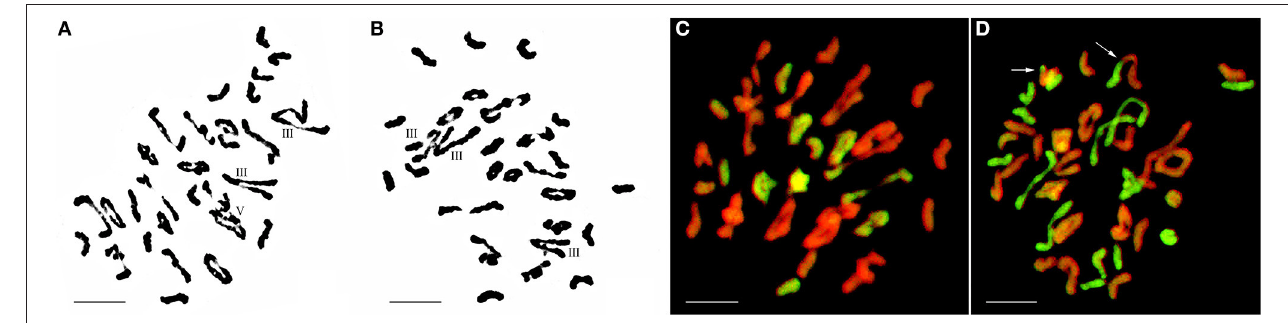
FIGURE 3 | Chromosome configuration in PMC MI for wheat- E. elongata F 2 hybrids. (A) Chromosome configuration of F 2 -1: 2 n = 10I + 14II + 2III + 1V; (B) Chromosome configuration of F 2 -2: 2 n = 7I + 18II + 3III; (C) E. elongata chromosome configuration of F 2 -1: 2 n = 5I + 6II; (D) E. elongata chromosome configuration of F 2 -2: 2 n = 10I + 5II. Wheat chromosomes were detected in red and E. elongata chromosomes or chromosome segments were visualized in green. The arrows indicate pairing between wheat and E. elongata chromosomes. Bar = 10 µ m.